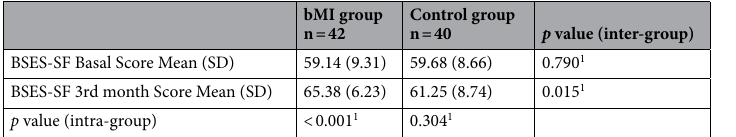
Table 3. Intra-group and inter-group comparison of breastfeeding self-efficacy. bMI brief motivational intervention, BSES-SF Breastfeeding Self-Efficacy Scale Short Form. 1 Student’s t-test.